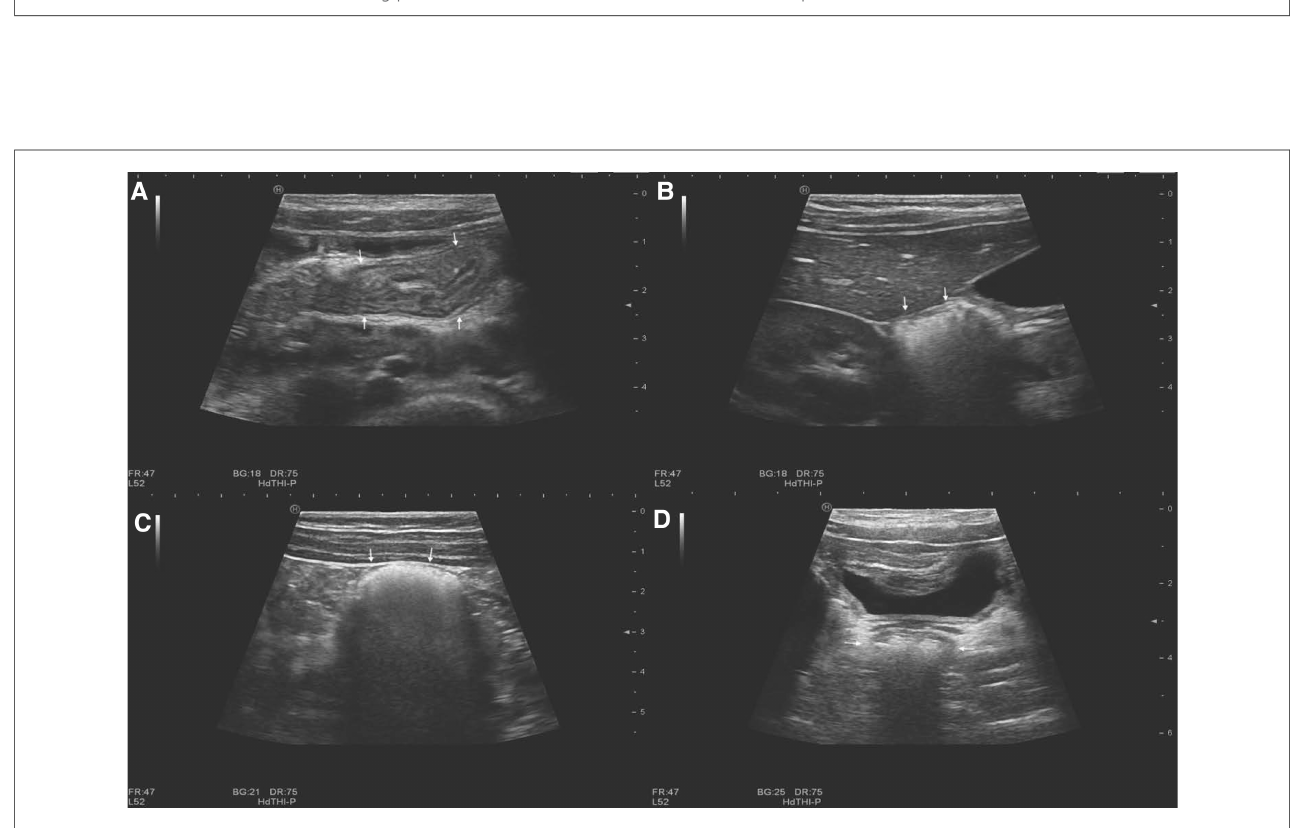
FIGURE 2 Normal gastrointestinal sonographic images obtained with high-frequency probes in a 5-year-old girl without magnets. Sonograms display the small intestine (arrow in A ), hepatic fl exure of the colon (arrow in B ), descending colon (arrow in C ), and rectum (arrow in D ).